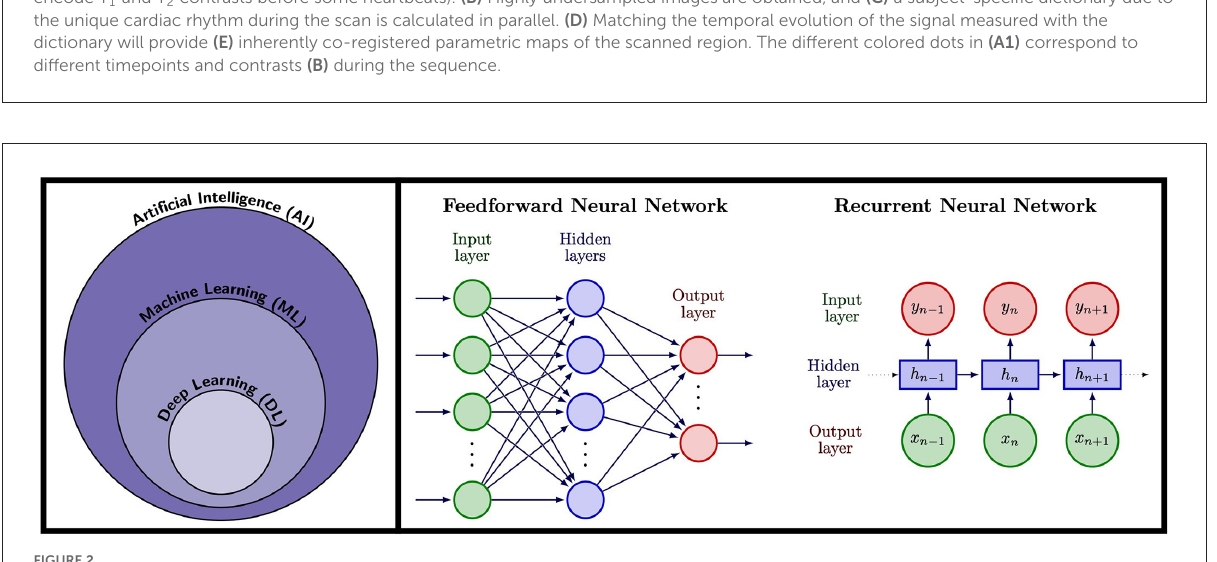
algorithm. The optimization algorithm measures the